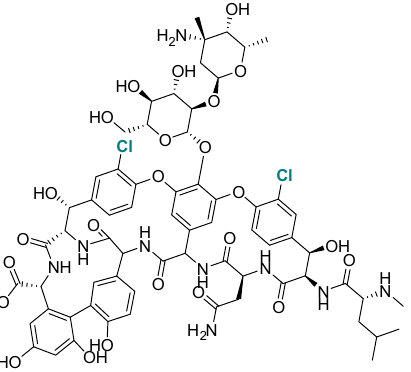
Figure 1. Structure of vancomycin, a natural antibacterial compound with activity against methicillin-resistant Staphylococcus aureus (MRSA).